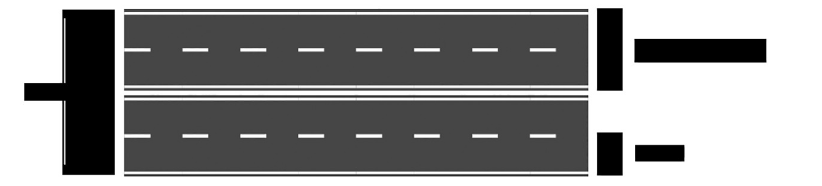
Fig 1. The various portions of a road as can be represented from an areal